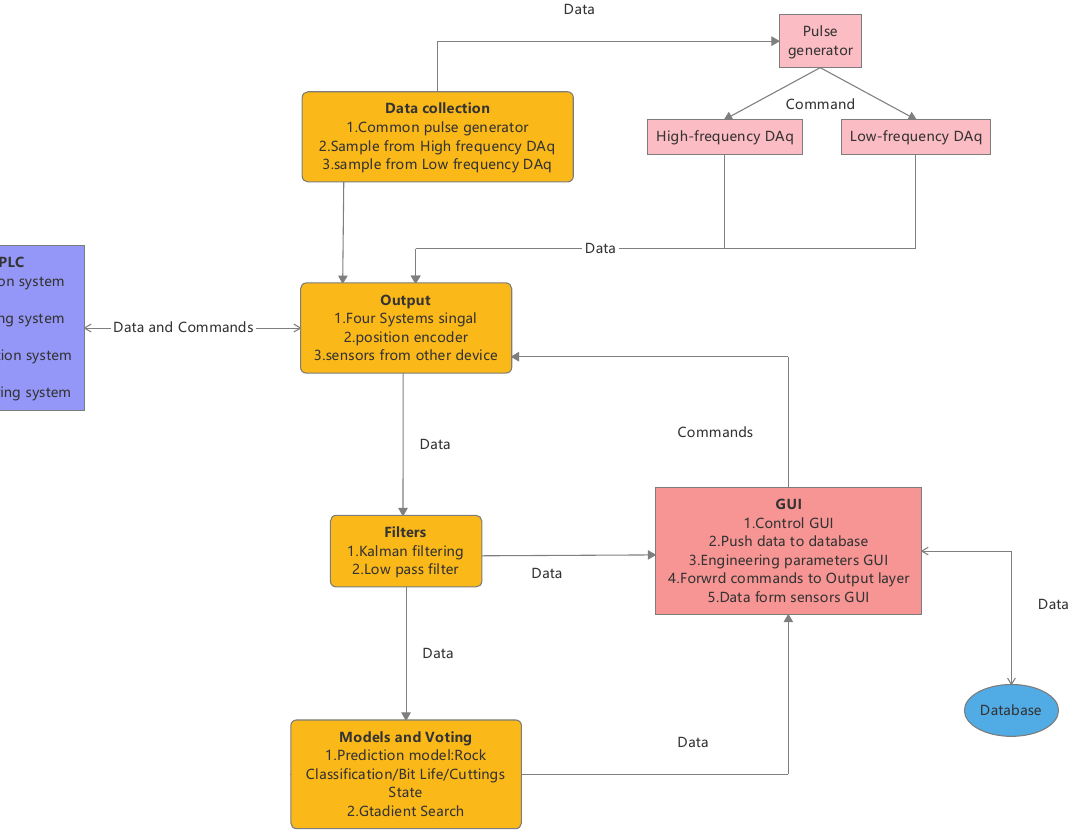
Figure 5. Control system layers and data flow with PLC and sensor.